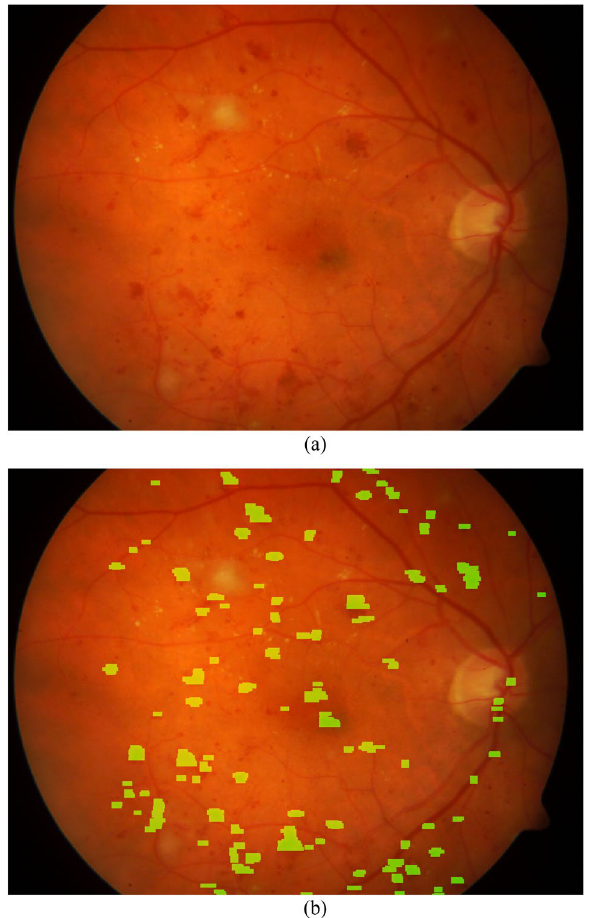
Figure 5. ( a ) A retinal fundus image, ( b ) the extracted